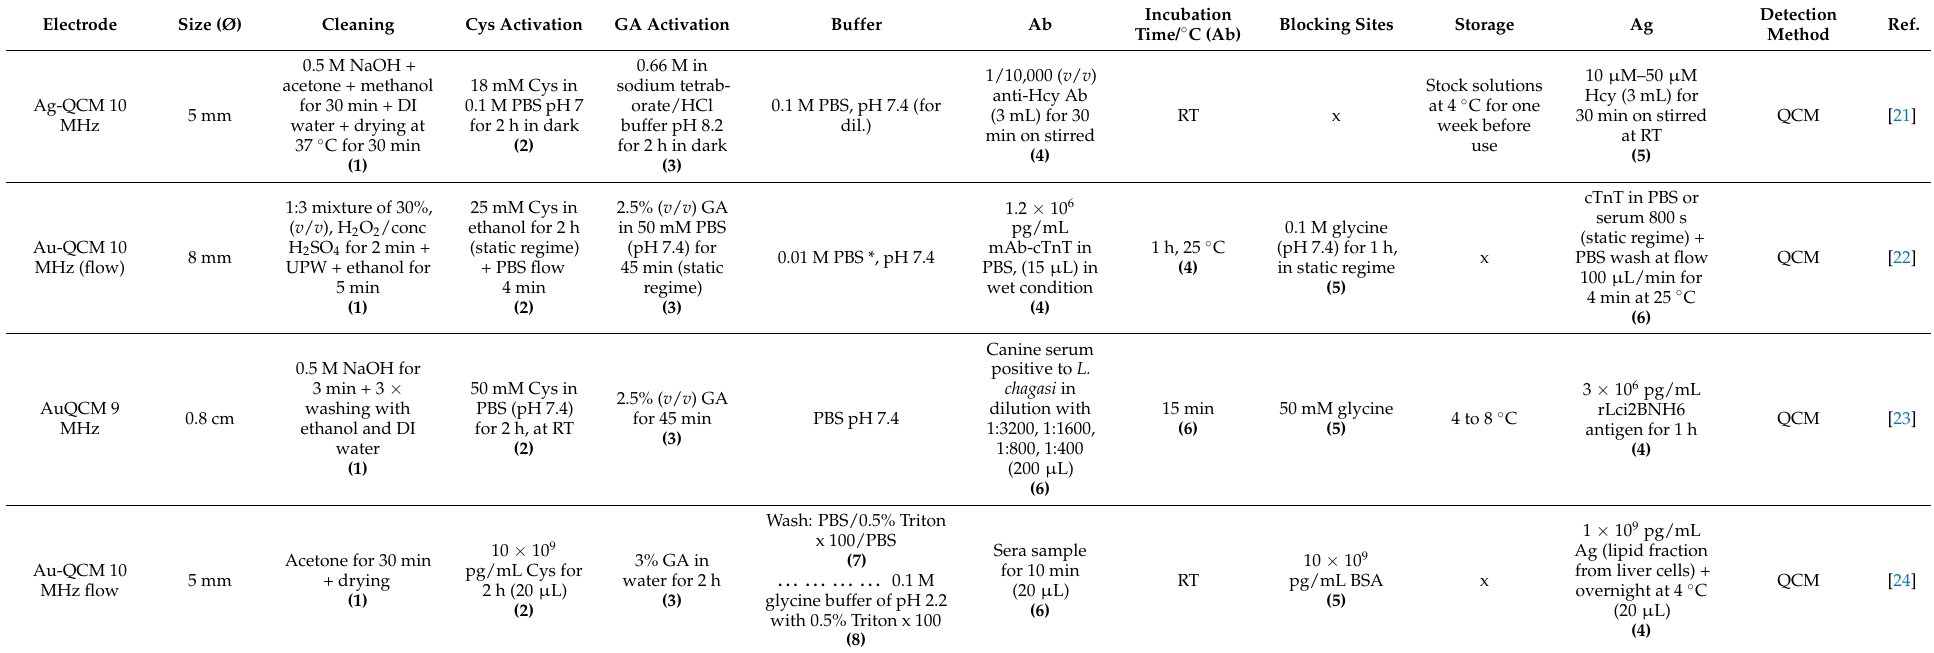
Table 1. Step-by-step (bio)functionalization of supports for piezoelectric detection of biomarkers on different various substrates.